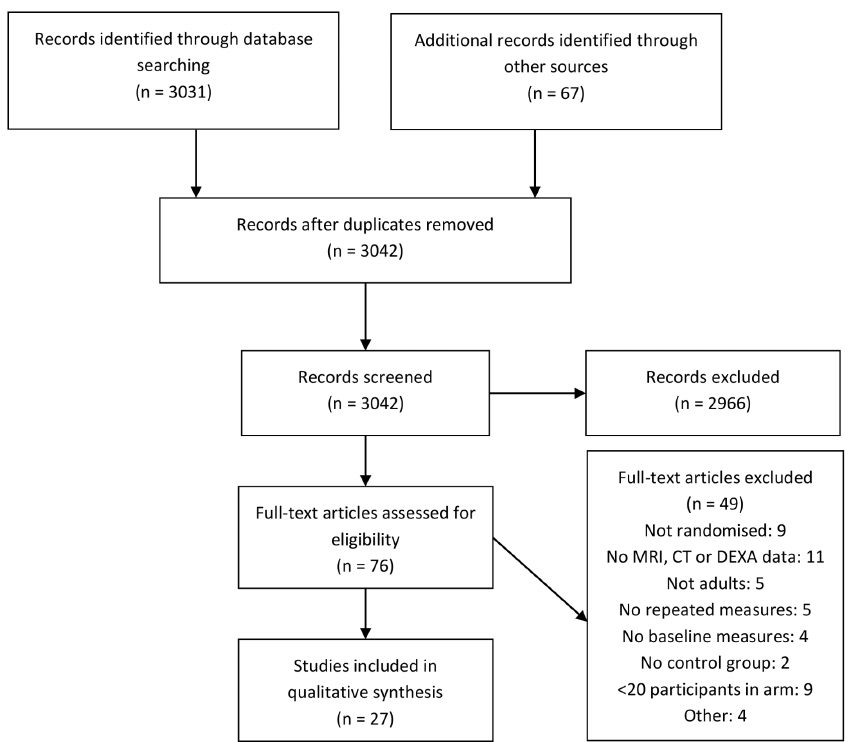
Figure 1. Flow diagram of study selection.